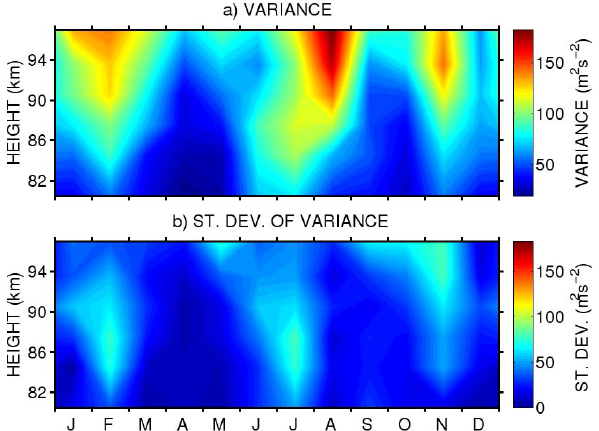
Fig. 5. (a) Monthly variance as a function of height for a composite year of all available data between 2005 and 2010 of zonal winds over Ascension Island. The winds are bandpassed between periods of 2.5–4.5 days. (b) The standard deviation of the monthly variance values for each height gate and each month.